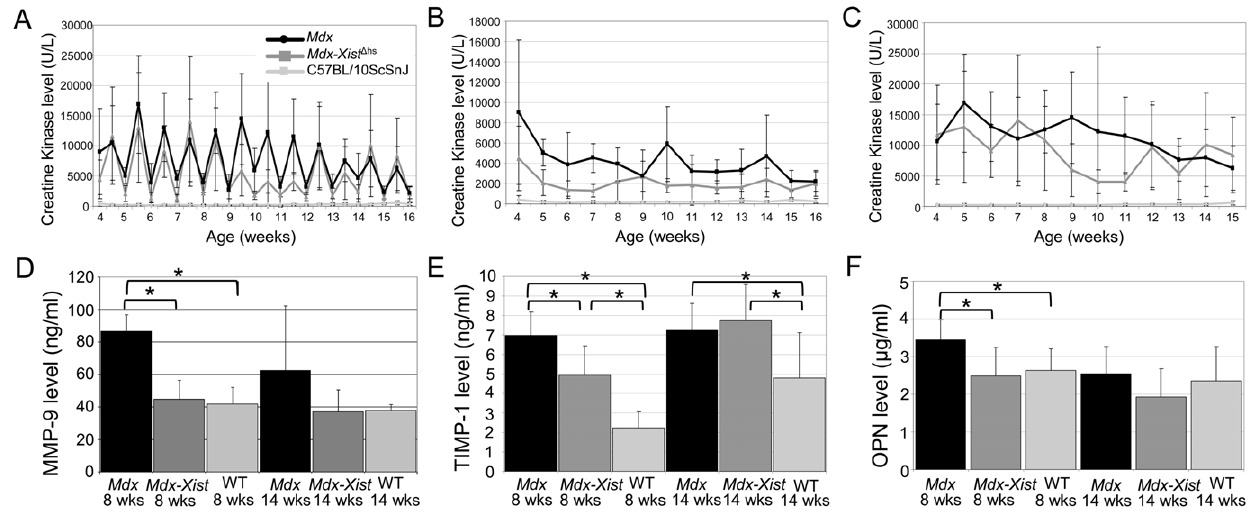
Figure 5. Serum and plasma biomarkers assessed before and directly after treadmill running. A. CK levels assessed before and directly after treadmill running. CK levels collected before exercise were significantly ( P , 0.01) lower than those collected directly after exercise in mdx-Xist D hs and mdx mice. This exercise induced increase was absent in wild type mice. B. CK levels determined before exercise were significantly ( P , 0.01) elevated in mdx and mdx-Xist D hs mice compared to wild type, but this was less pronounced for the mdx-Xist D hs mice as mdx mice had significantly ( P , 0.05) higher CK levels. C. Plasma collected directly after exercise contained extremely high CK levels, in both mdx and mdx-Xist D hs mice but not in wild type mice. D. Serum levels of MMP-9 were elevated in mdx mice compared to Xist D hs mice at both 8 and 14 weeks of age, while levels were normalized in mdx-Xist D hs mice. E. TIMP-1 levels were elevated in serum of both mdx and mdx-Xist D hs mice. In wild type mice we found an age related increase of the serum TIMP-1 level. Interestingly, at the age of 8 weeks, levels of mdx-Xist D hs mice were significantly lower than those of mdx mice. F. Mdx mice had significantly elevated OPN levels compared to both wild type and mdx-Xist D hs at 8 weeks of age. Single asterisks indicate a P , 0.05, average dystrophin level of mdx-Xist D hs mice was 21% (2%–45% median